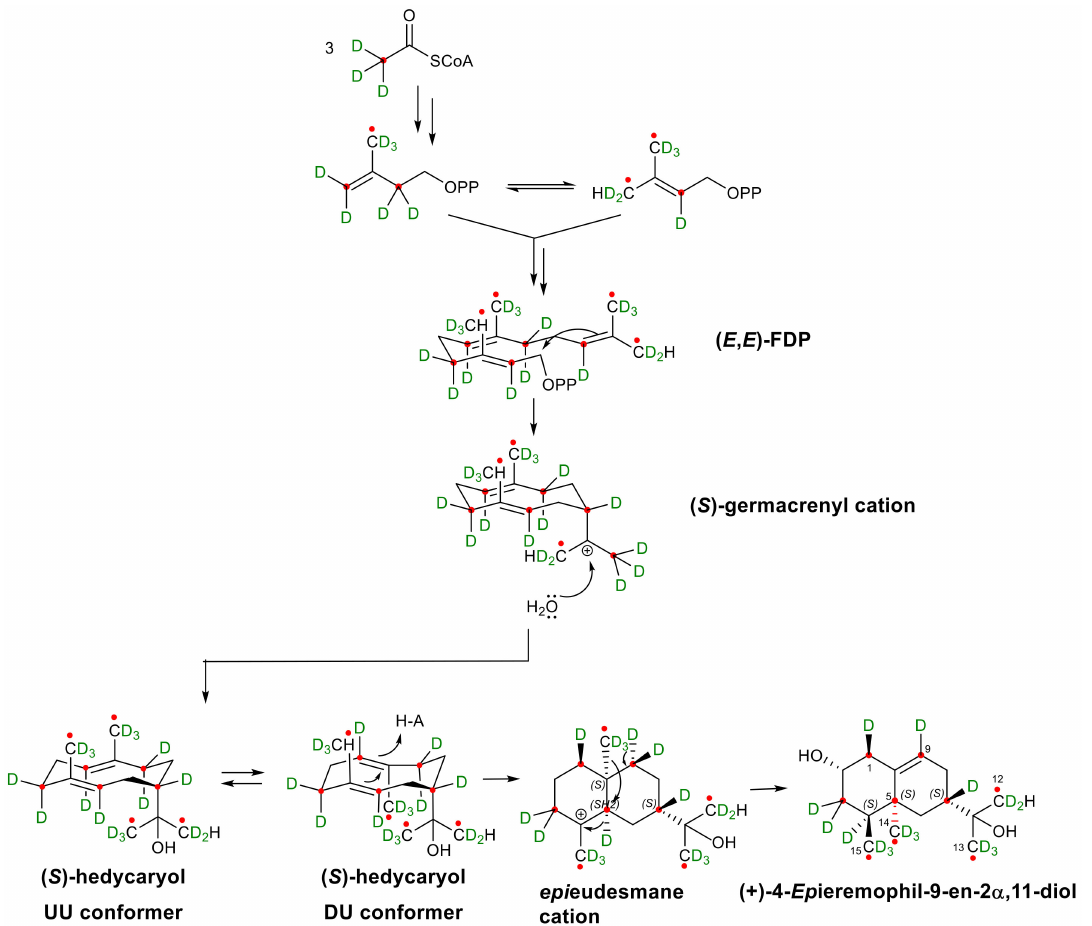
Figure 14. Proposed biosynthetic route to ( + )-4- epi